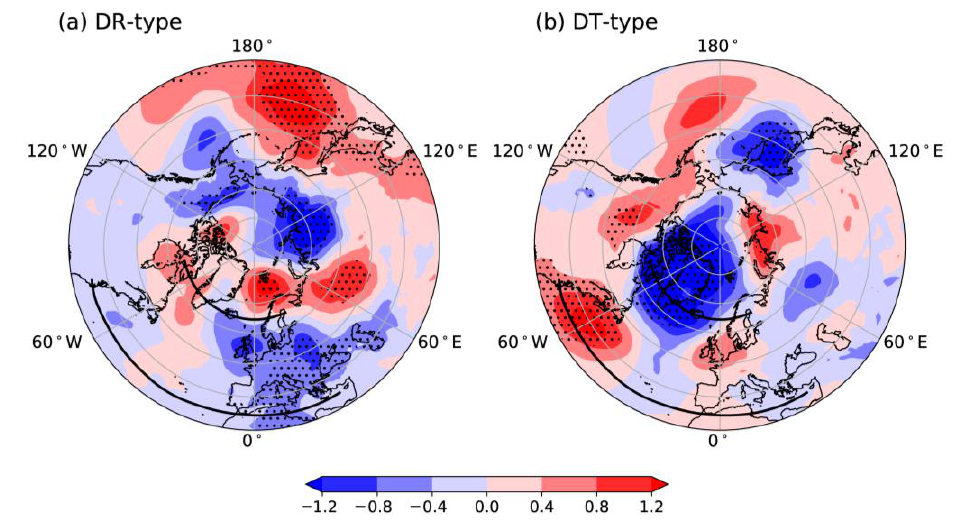
8 of 19 Figure 4. Composite summer vertical integral of moisture flux anomalies (vector, units: kg·m −1 ·s −1 ) and its divergence anomalies (shading, units: 10 − 6 kg·m −2 ·s −1 ) for ( a ) DR-type and ( b ) DT-type. The moisture flux divergence anomalies significant at the 90% confidence level are dotted. 3.2. The Connection between Summer NAO and Circulation Types over Eurasia The anomalous circulation over Eurasia can be attributed to the NAO [19 – 21]. To investigate whether the summertime circulation types over Eurasia are linked to the NAO, the composite summer SLP anomalies are shown in Figure 5. The distribution of SLP for the DR-type (Figure 5a) is characterized by a north – south-orientated seesaw pattern over the North Atlantic. A positive anomalous center is observed over Greenland, and a nega-